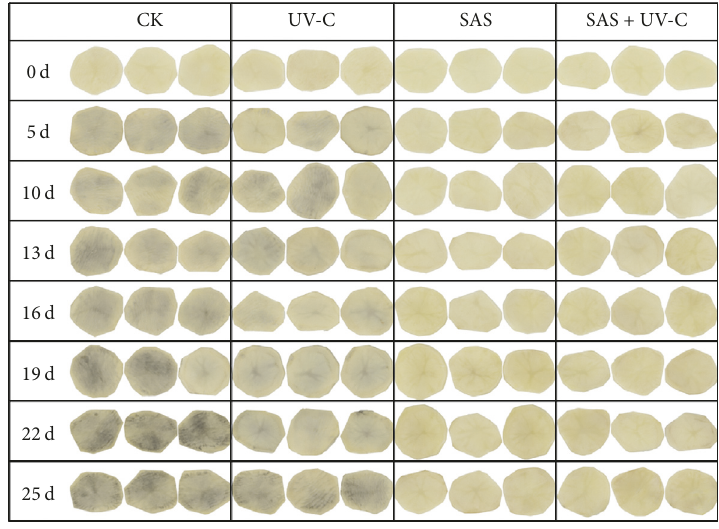
Figure 2: Effects of SAS, UV-C, and SAS + UV-C on appearance of fresh-cut potatoes during storage.